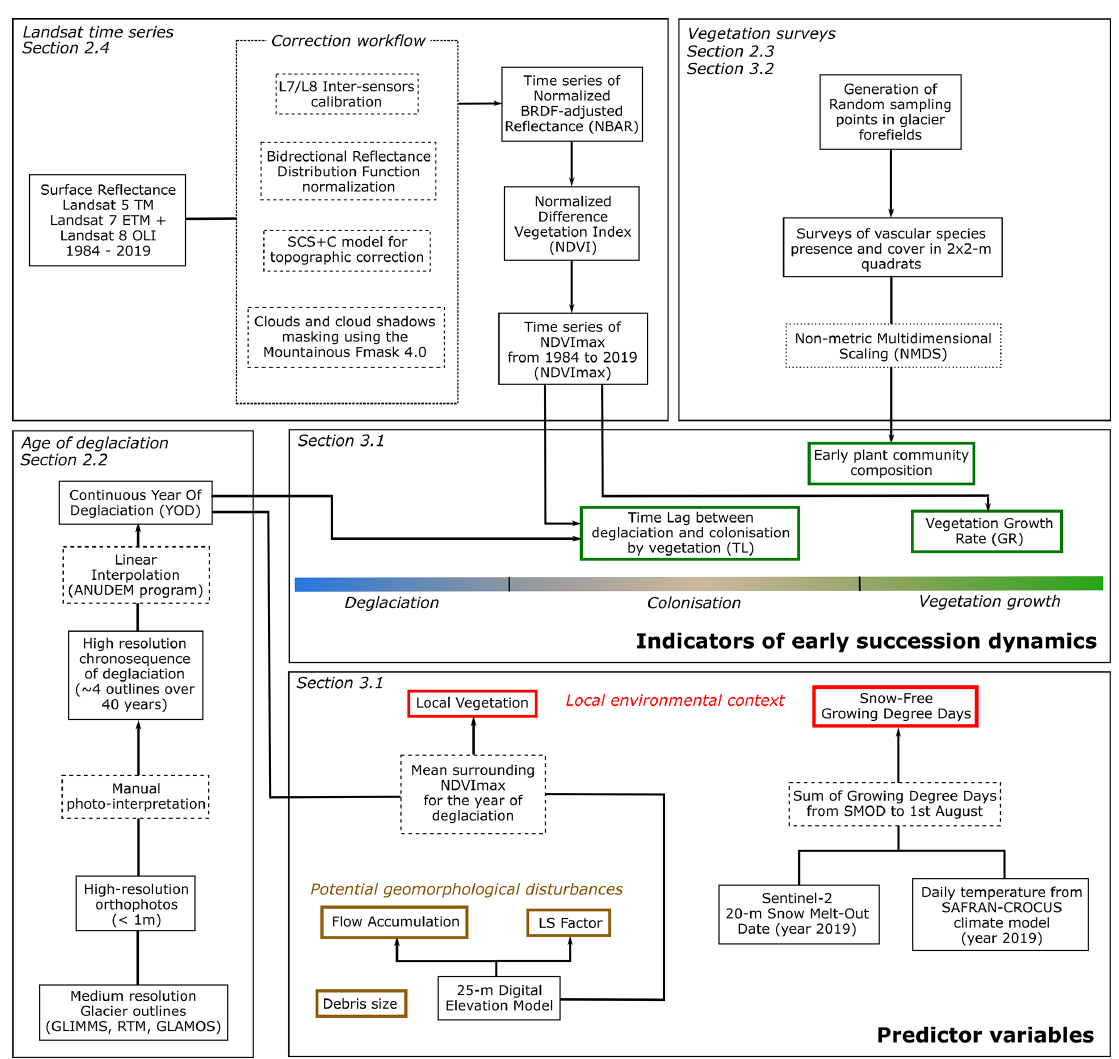
Figure 2. Complete analysis workflow shown by methodological sections. Indicators of early succession dynamics are shown in green, while predictor variables are shown in red and